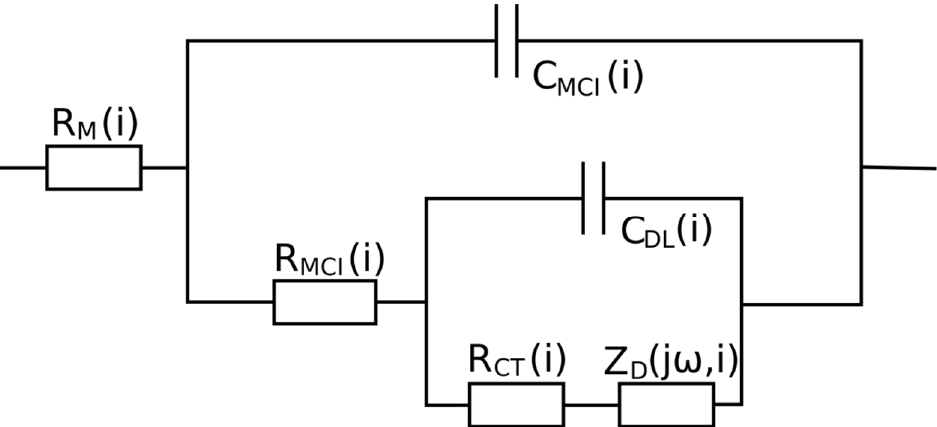
Figure 4. Electrical equivalent circuit employed for analyzing the instantaneous impedance spectra. R M ( i ) —sum of instantaneous resistance of the membrane and processes of hydrogen oxidation, R MCI ( i ) —instantaneous resistance of the interlayer on the cathodic site, R CT ( i ) —instantaneous charge transfer resistance of oxygen reduction, Z D ( j ω , i ) instantaneous impedance of the element describing diffusion in a finitely thick layer, C MCI ( i ) instantaneous capacitance of the catalyst-membrane interlayer on the cathodic site, and C DL ( i ) —instantaneous capacitance of the electrical double layer on the cathodic site.